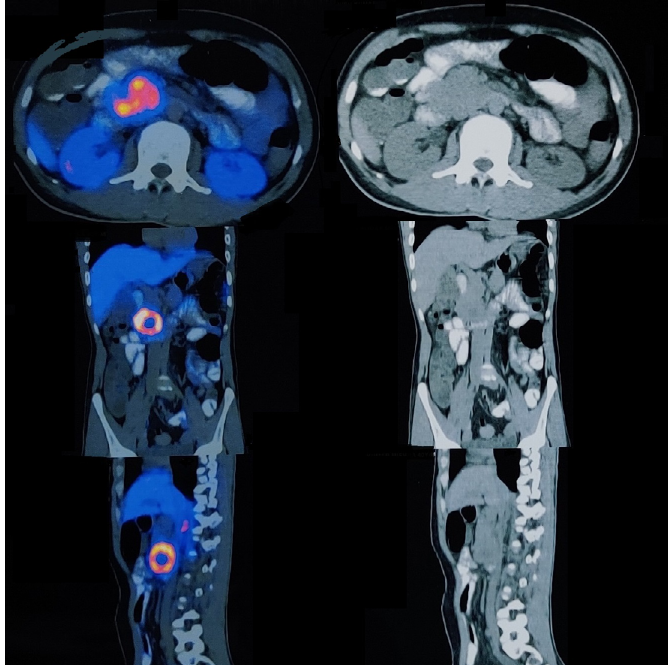
Figure 2. Axial, coronal, and sagittal section images of 68 Ga DOTANOC PET CT scan showing enhancing lesion in the head of pancreas